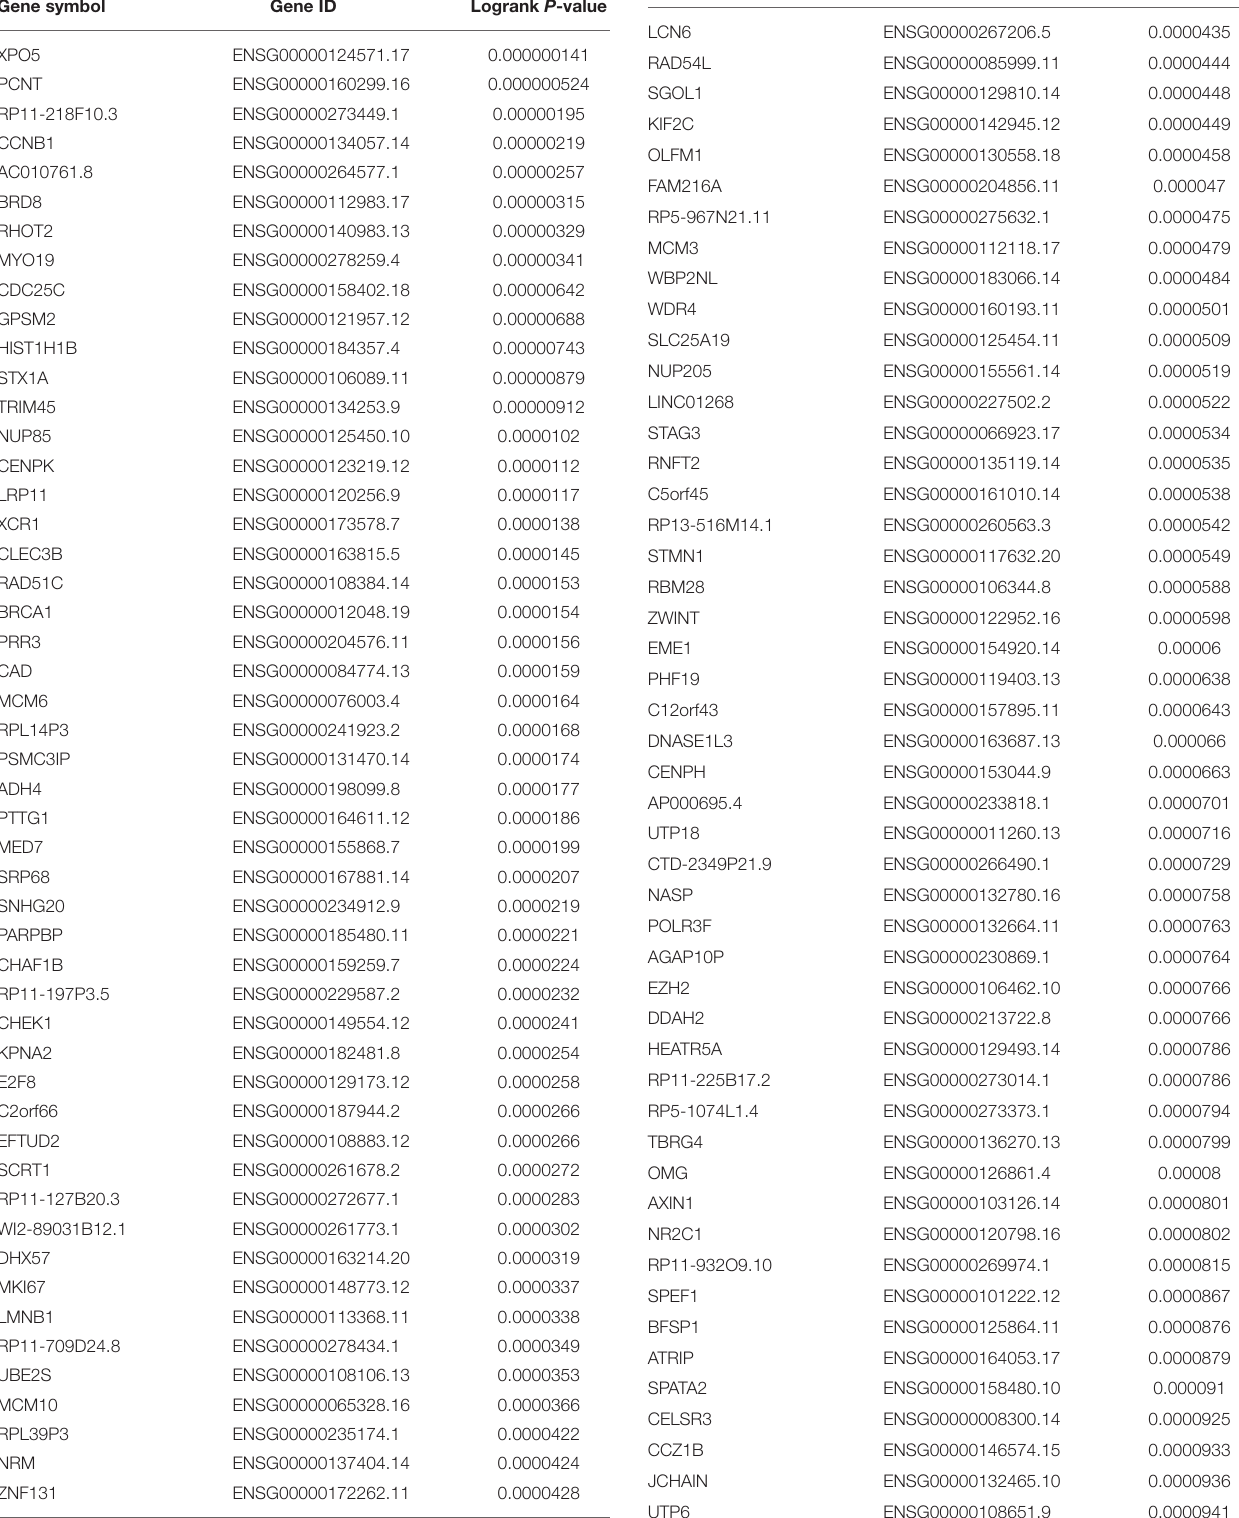
TABLE 2 | The genes most associated with disease-free survival (RFS) of patients with hepatocellular carcinoma determined by GEPIA